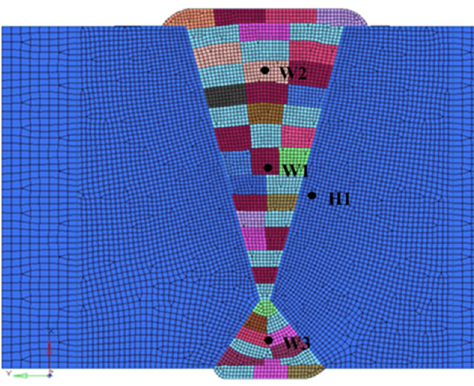
Figure 3. Welded joint grid model.